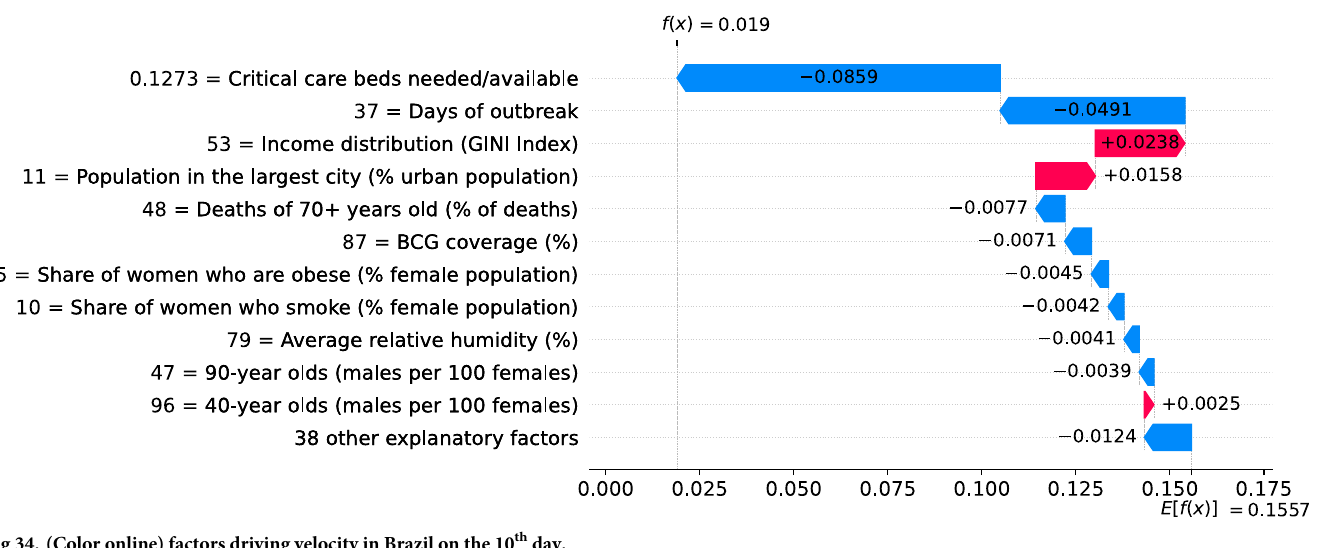
Fig 34. (Color online) factors driving velocity in Brazil on the 10 th